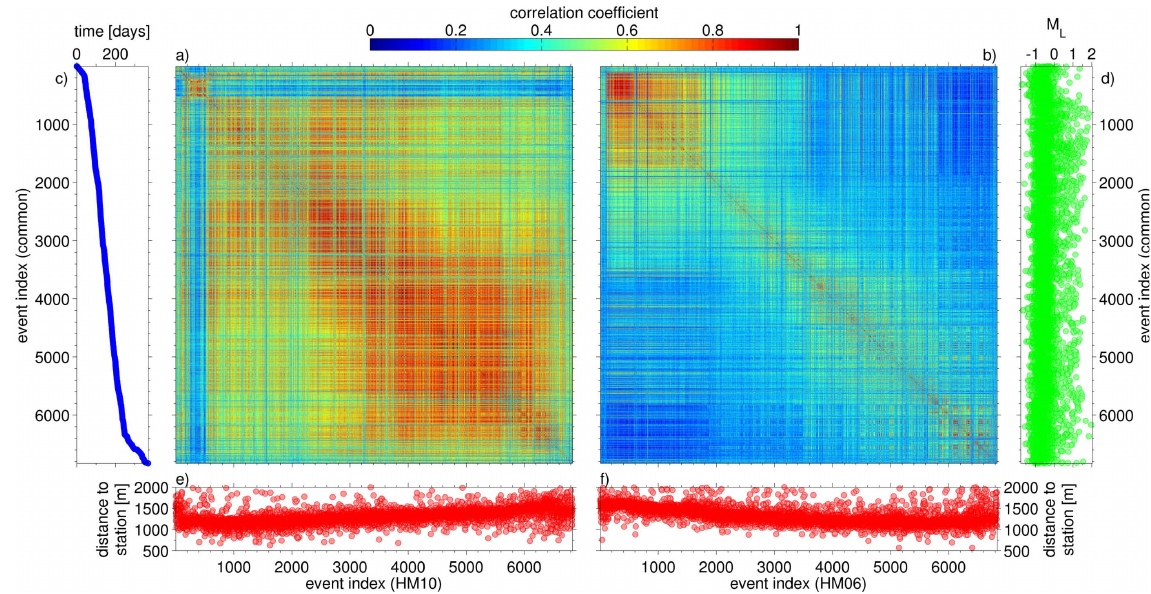
Fig. 3. Similarity matrices for two stations at opposing ends of the longwall. Event migration is away from HM10 (a) and towards HM06 (b) which were situated at the southwestern and the northeastern end of the longwall panel, respectively (see Fig. 1). (c) and (d) show the temporal and the magnitude distribution of the events. (e) and (f) depict event to station distance for the particular station–event combination, indicating a positive correlation between correlation coefficient and station–event